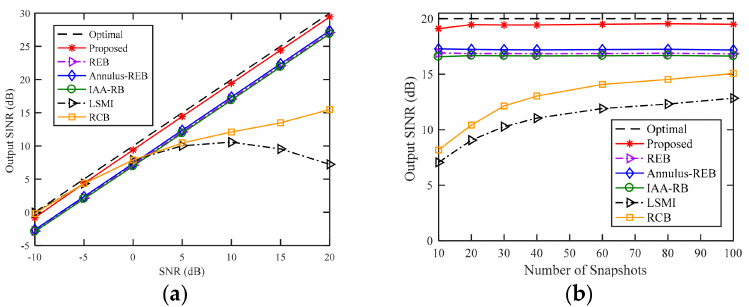
Figure 2. Output SINR versus ( a ) SNR ( b ) number of snapshots with random signal direction error and sensor